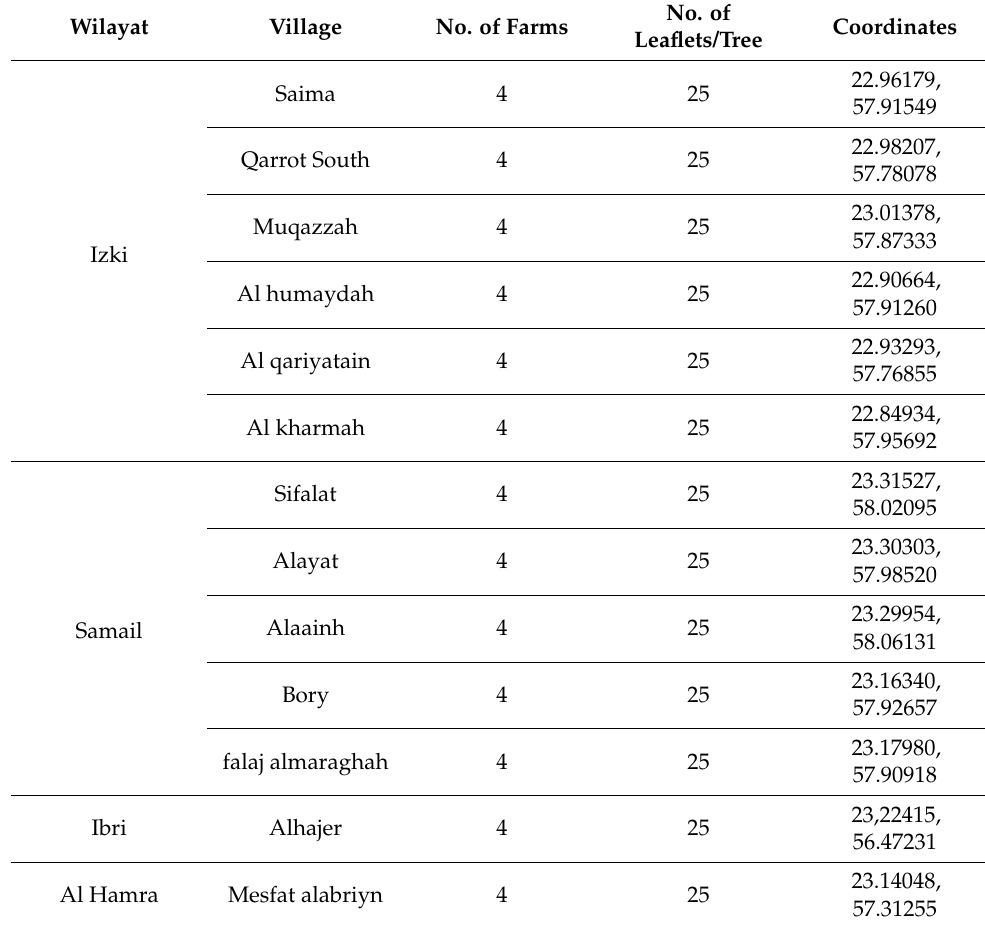
Table 1. Sample collection of date palm leaves infested with dubas bug in different administrative units in